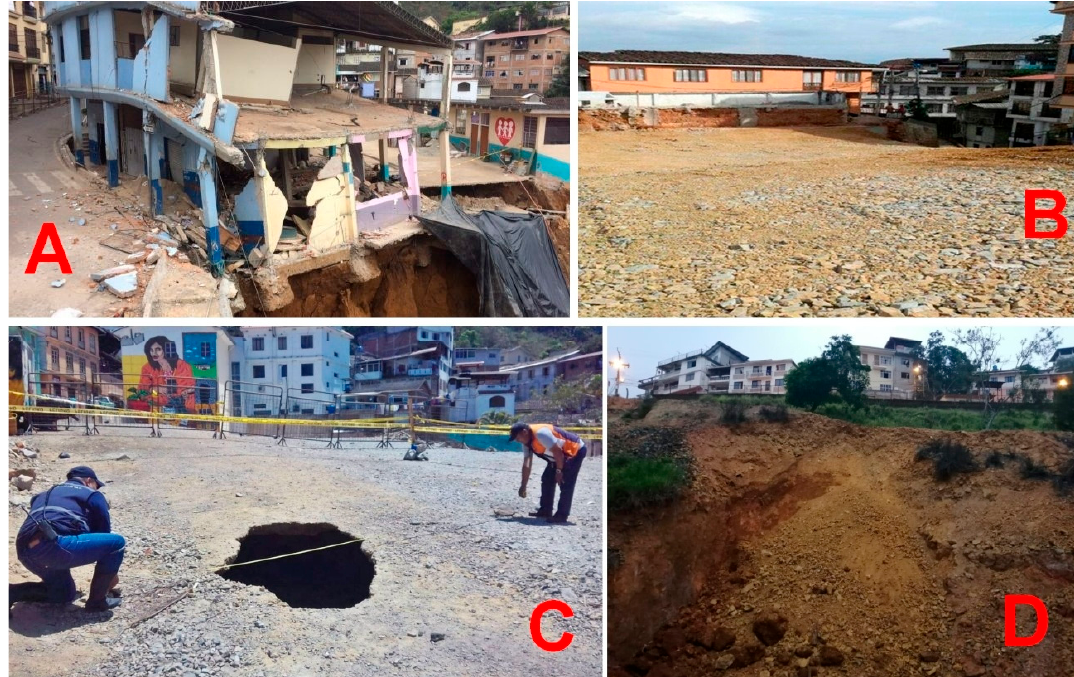
Figure 3. ( A ) Collapse of the Fe y Alegría School, in October 2916. ( B ) Technical filling done at the site in 2017. ( C ) Reactivation of the collapse in the place where the school was in 2017. ( D ) New collapse near Gonzalo Pizarro Street in 2019. Images taken from El Expreso Newspaper, Ecuador en vivo, Pichincha Universal and Arden los Socavones Facebook page.